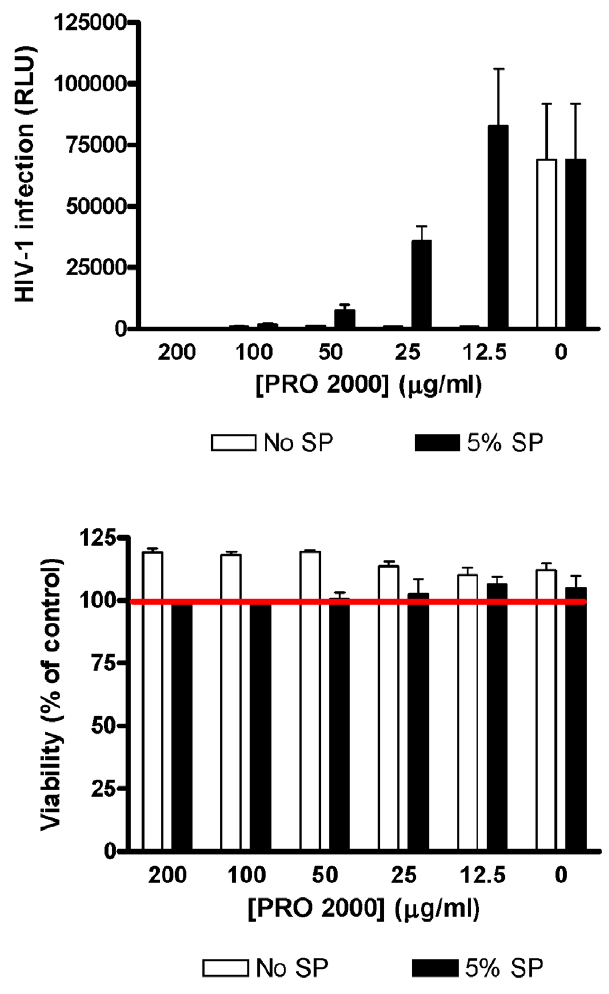
Figure 5. Seminal plasma interferes with anti-HIV activity of PRO 2000 in cell culture. TZM-bl cells were infected with HIV-1 BaL that had been diluted in media (no SP) or media containing 5% pooled SP and mixed 1:1 with serial 2-fold dilutions of unformulated PRO 2000 diluted in pooled CVL obtained from healthy controls. Results are mean 6 sd obtained from triplicate wells and are representative of 3 independent experiments (upper panel). Cell proliferation was assessed in parallel in uninfected plates treated with the CVL and pooled SP for 48 h (lower panel). Results are expressed as % viability (relative to mock-treated controls) and are means 6 SD of 2 independent experiments where each condition was tested in triplicate.